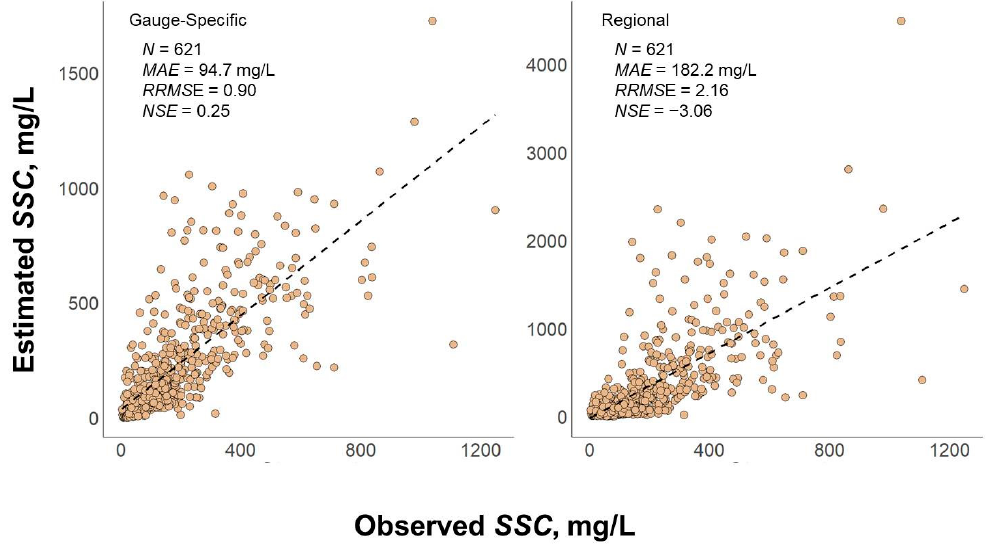
Figure 10. Comparison of gauge-specific ( left ) and regional ( right ) SSC-SR models for the Upper Mississippi River. Note the different y -axis scales. The dashed line represents the 1:1 relationship.